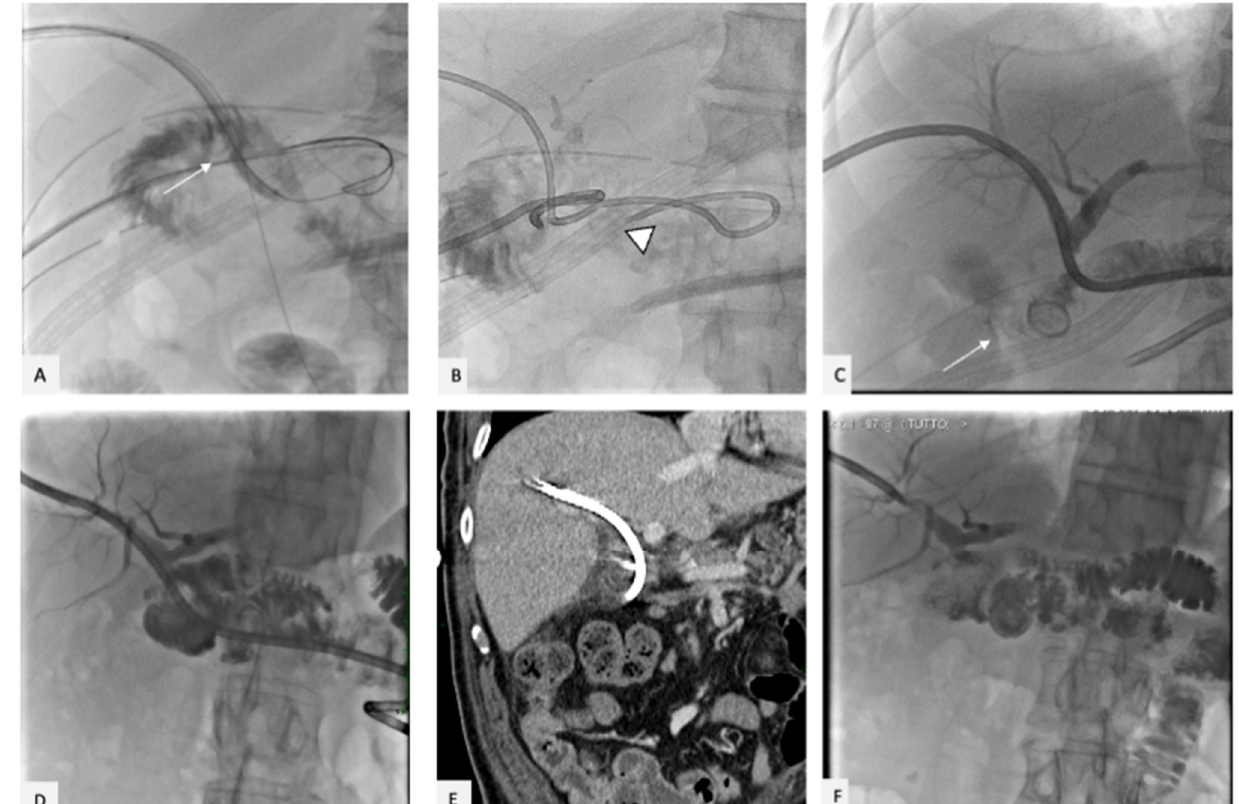
Figure 7. ( A ) Percutaneous bilioplasty with a 10 × 70 mm balloon (arrow) performed to solve the stenosis. ( B ) Transhepatic biliary drainage (8 Fr) positioned into the jejunal loop (arrowhead), completing the biliary rendez-vous. Another 8 Fr drainage was left into the jejunal loop and then ( C ) replaced after one week with a 4 Fr pig-tail catheter (arrow) to avoid the creation of an enteric fistula. One month after the rendez-vous, the percutaneous cholangiography ( D ) showed no evidence of residual stenosis. ( E ) CT scan performed two months after the rendez-vous displaying the absence of collections and no dilatation of the biliary tree. ( F ) Five months after the rendez-vous, the percutaneous cholangiography showed no residual stenosis.